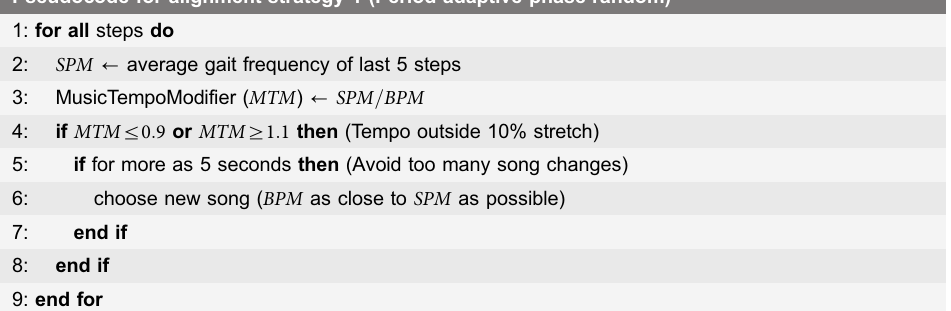
Table 1. Algorithm 1. Pseudocode for alignment strategy 1 (Period-adaptive